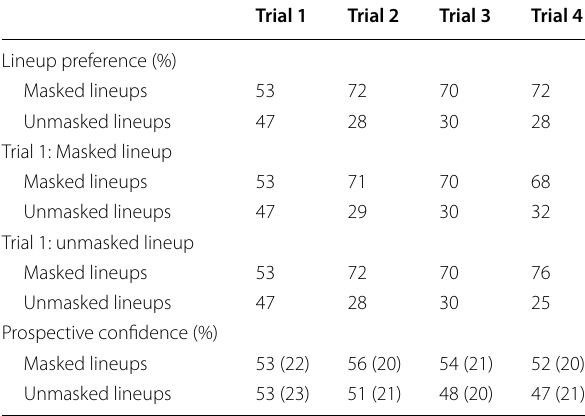
Table 4 Lineup preference proportions and prospective confidence ratings across trials in Experiment